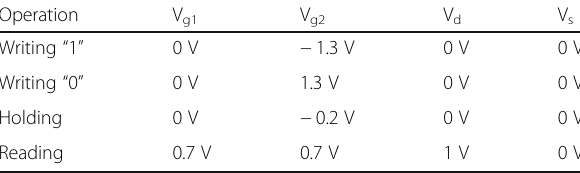
Table 1 Optimized programming condition for DGTFET DRAM